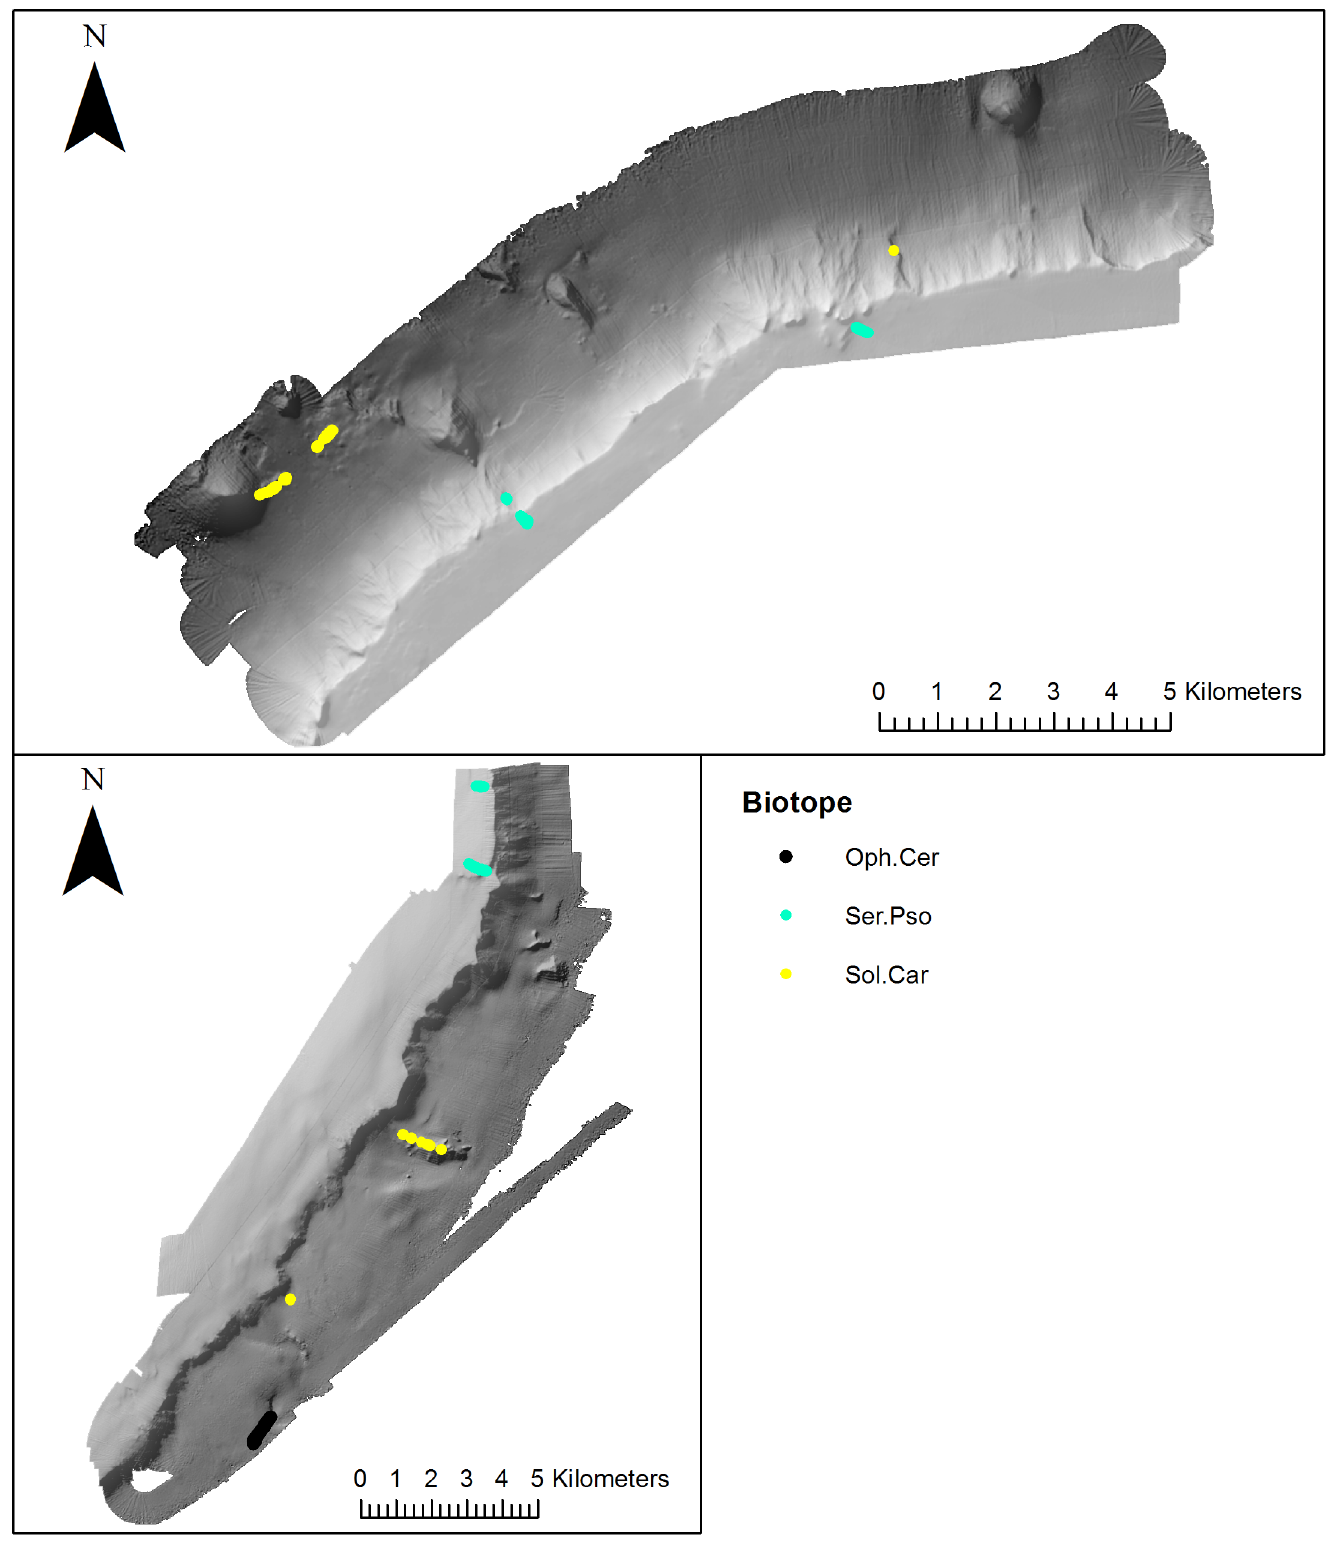
Fig 10. Distribution of non-VME biotopes (mapped using video footage) biotopes on the NW and SE side of Anton Dohrn Seamount. Refer to Fig 2 for bathymetric scale.